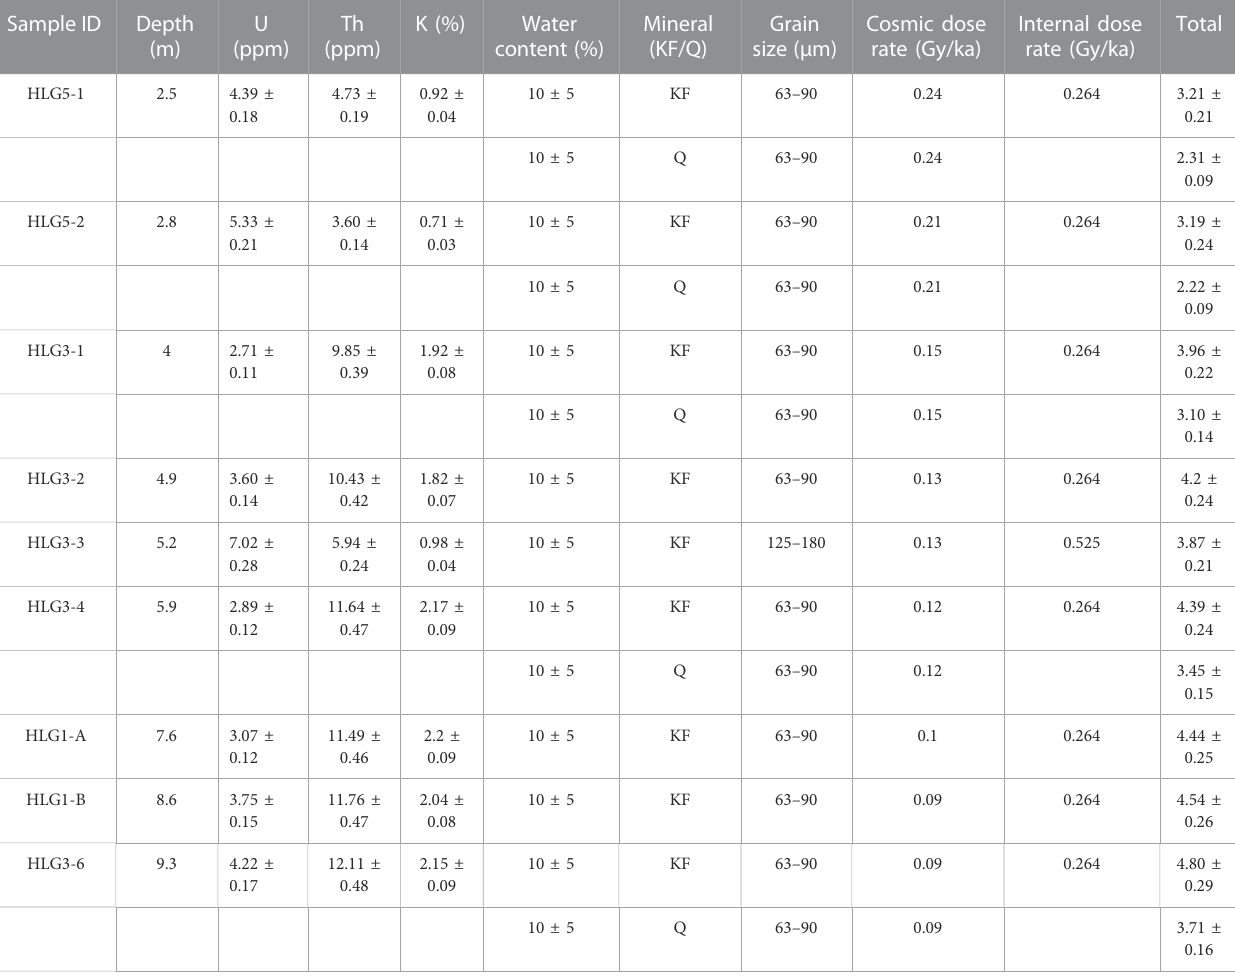
TABLE 1 Dose rates of all quartz and KF